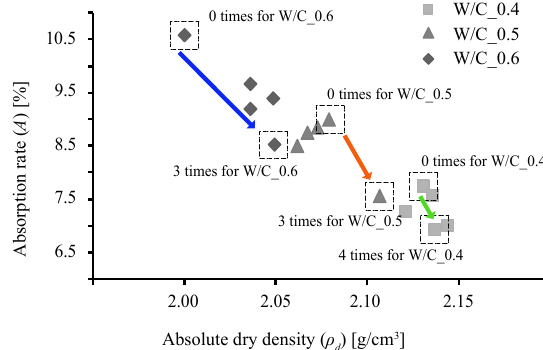
Figure 5. Relationship between absolute dry density and rate of water absorption.